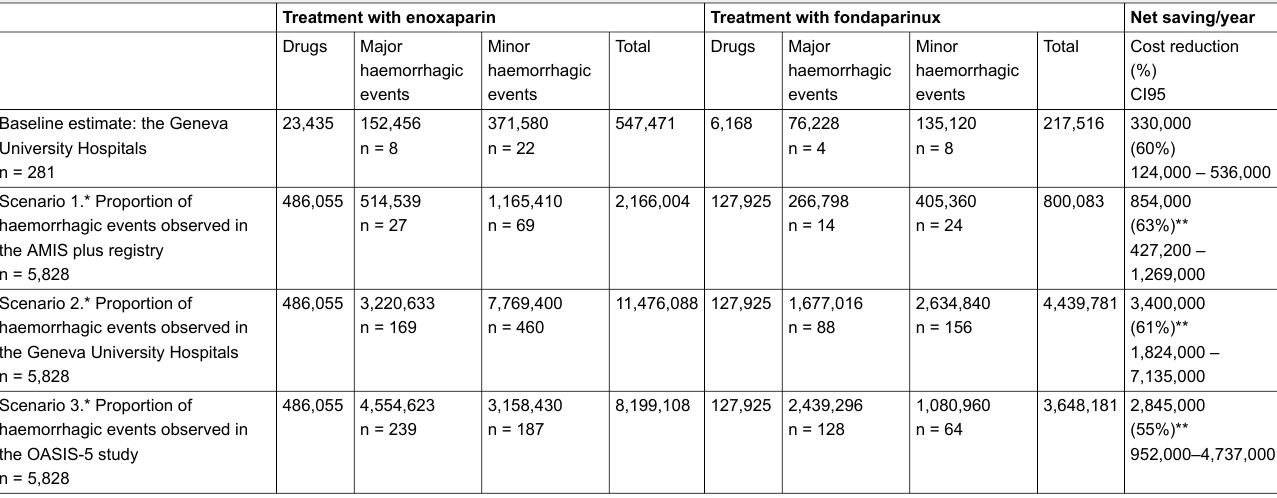
Table 4: Cost comparison between Enoxaparin and Fondaparinux according to the different scenarios. Treatment with